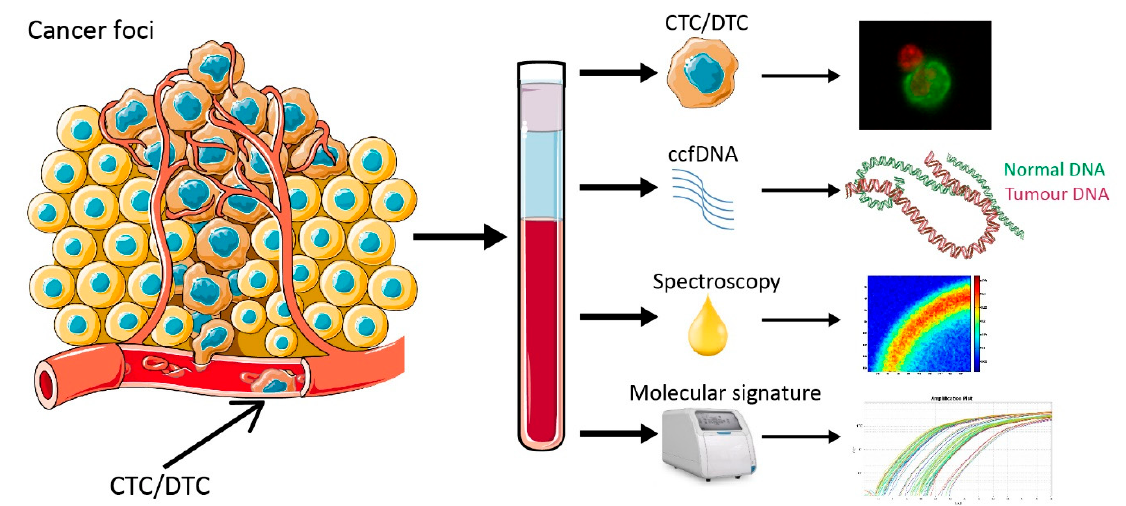
Figure 7. Different types of assessment from a single liquid biopsy. CTC: circulating tumour cells, DTC: disseminated tumour cells, ccfDNA: circulating cell-free DNA.